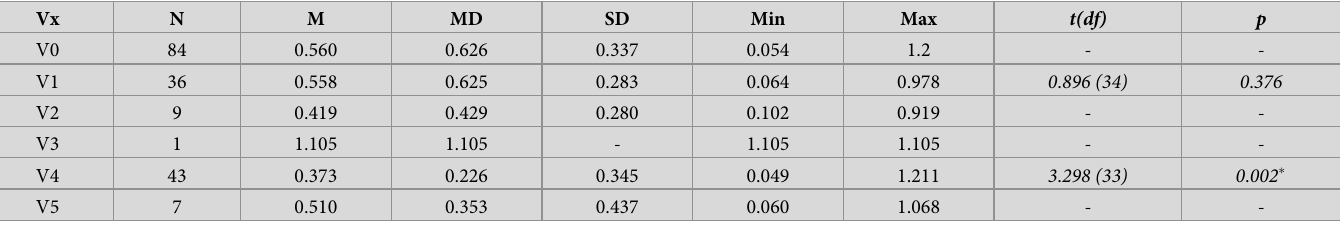
Table 4. Reactivity (indicated as optical densities OD) of IgG4 to larval extract of E. multilocularis (EmAg) over time and difference of respective levels compared to baseline. Vx = follow-up visit with V0 = baseline, N = number, M = mean, MD = median, SD = standard deviation; Min. = minimum, Max. = maximum, t = difference in units of standard error, df = degrees of freedom, p -value = significance level with � considered significant.